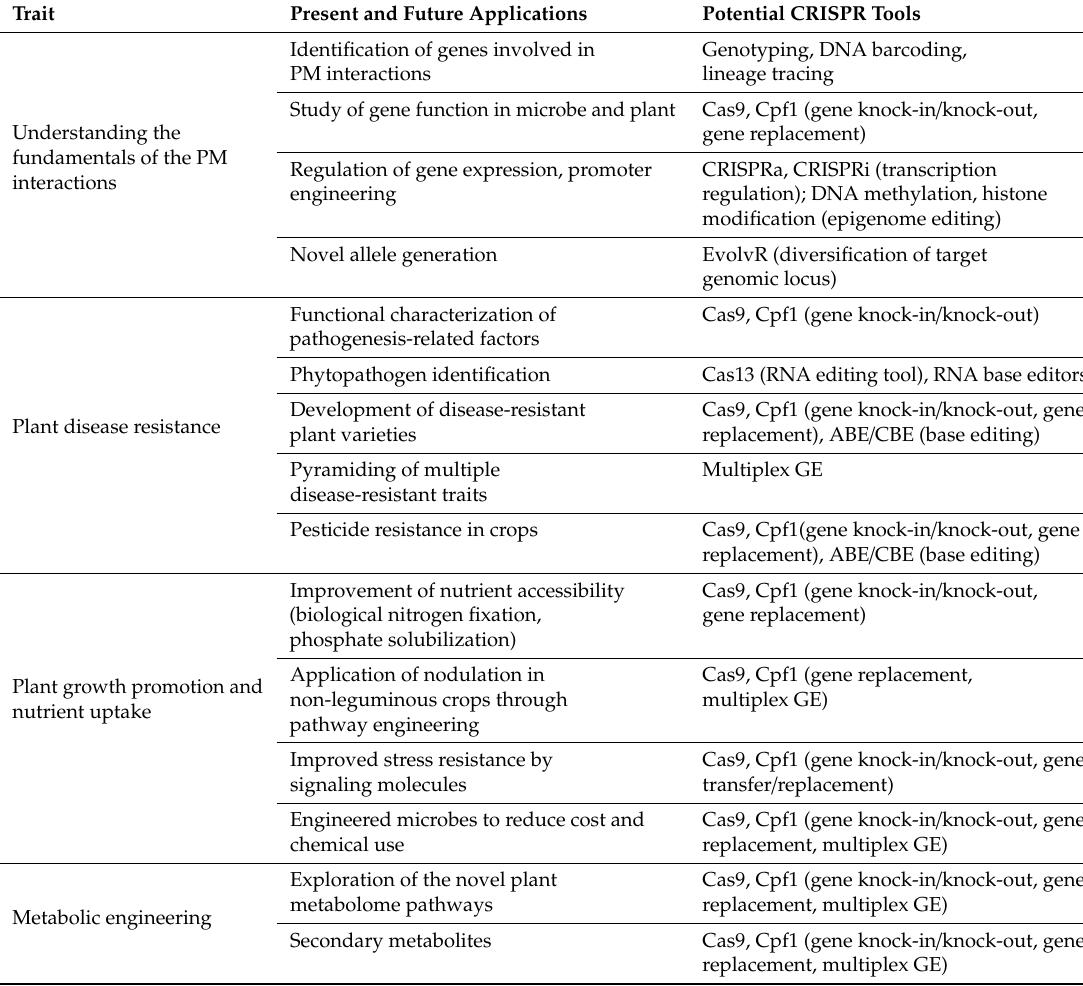
Table 3. Potential applications of genome-editing in plant–microbe interaction are summarized.